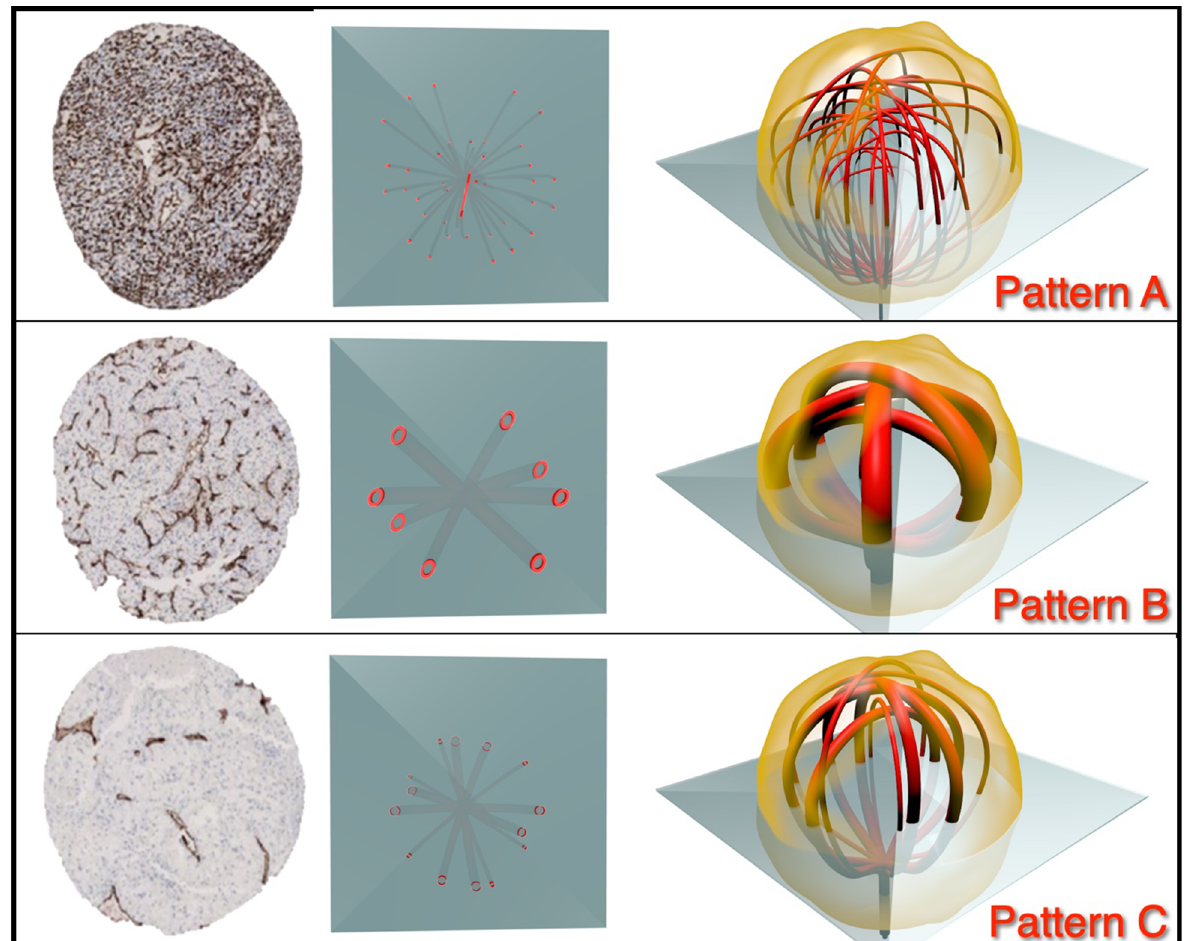
Figure 4. Classification of angiogenesis in clear cell RCCs after 3D fusion multisite tumor sampling. Diagram showing categorization of pattern of angiogenesis: pattern A, characterized by homogeneous high level of angiogenesis; pattern B , characterized by homogeneous low level of angiogenesis; and pattern C , characterized by a mixture of patterns.